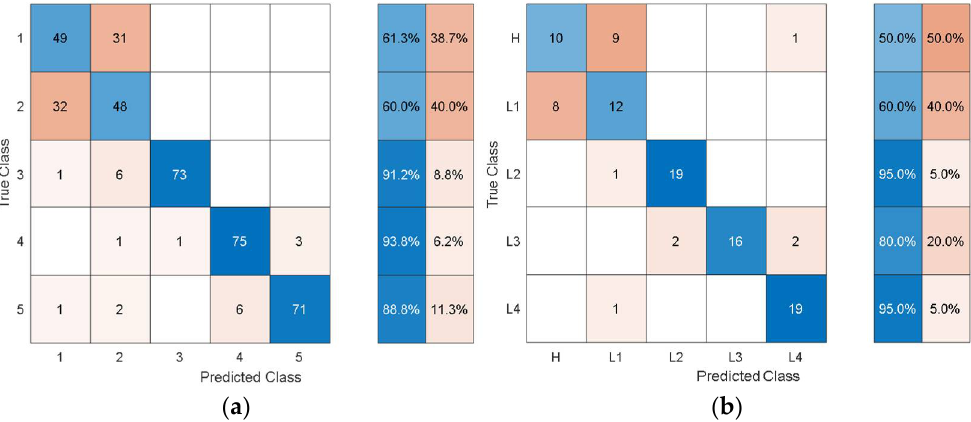
Figure 12. Classification performance of SVM using the autonomous features form the 68th layer of ResNet-18 in terms its confusion matrices: ( a ) training; ( b ) test.